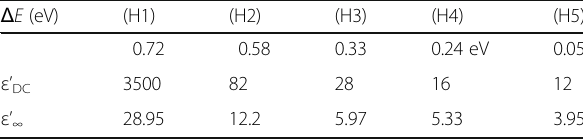
Table 1 Fitting parameters for AC-complex conductivity: electric conductivity and dielectric